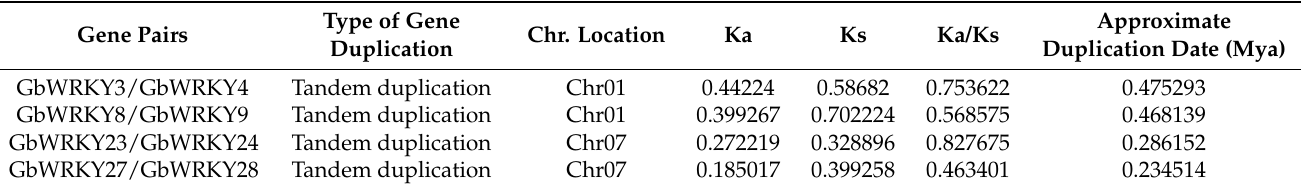
Table 2. Ka and Ks calculation of GbWRKY gene tandem and segmental duplication.